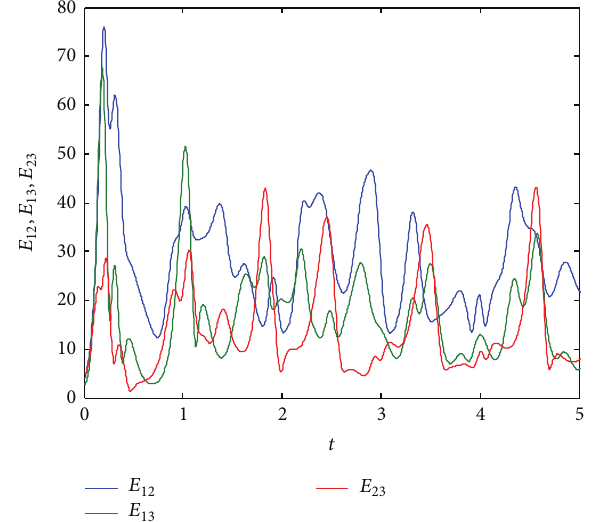
Figure 3: Time evolution of synchronization error 𝐸(𝑡)